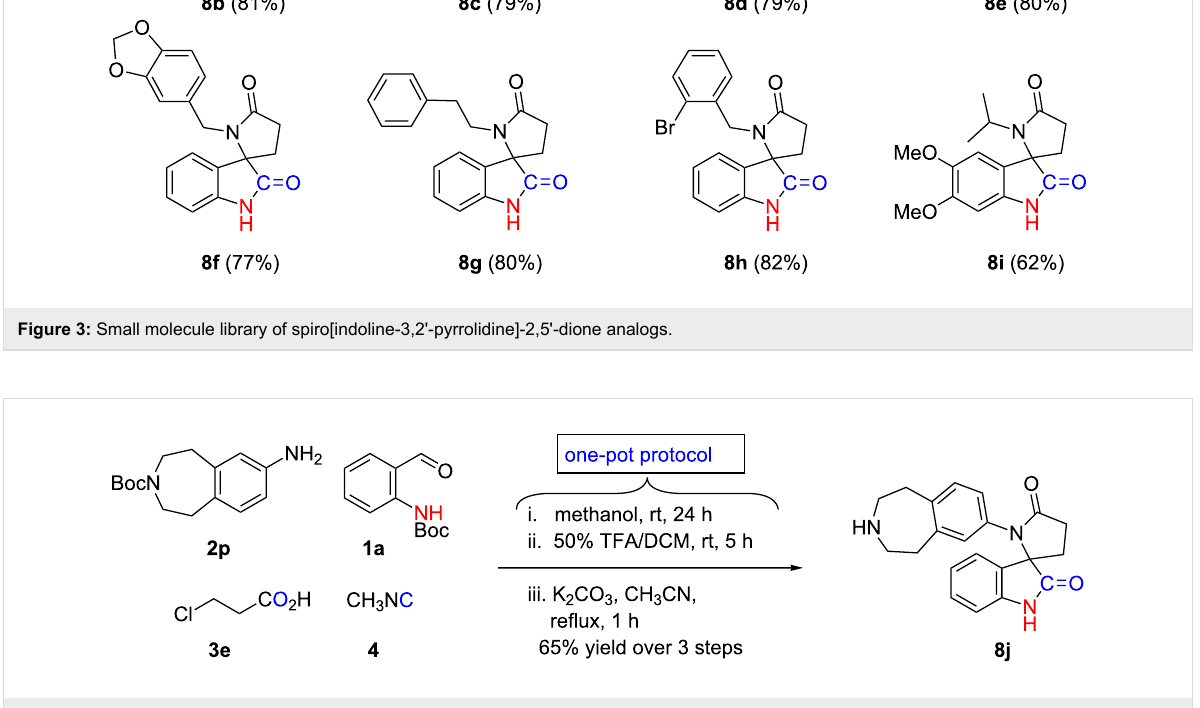
Scheme 6: Method applicability for the one-pot synthesis of 5-HT6 receptor antagonist 8j